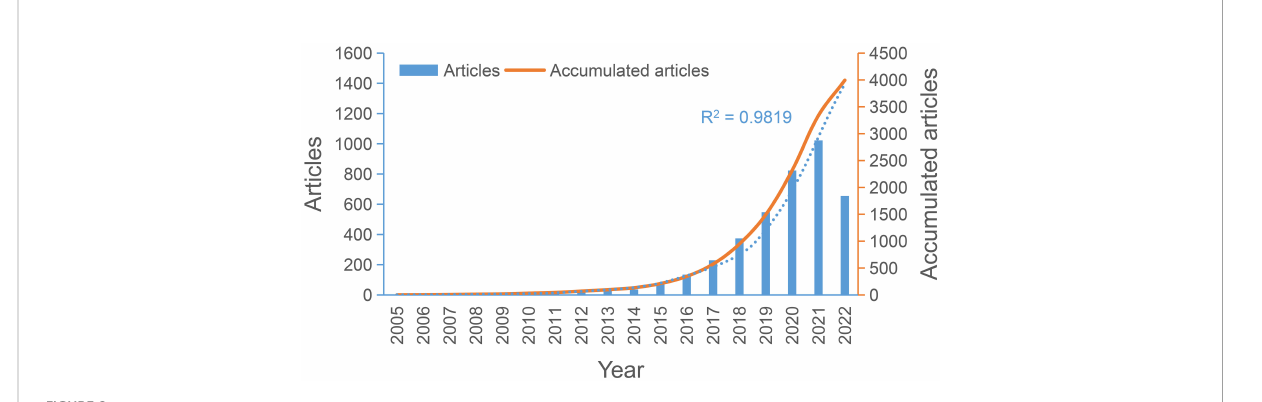
FIGURE 2 The number of publications per year and the cumulative